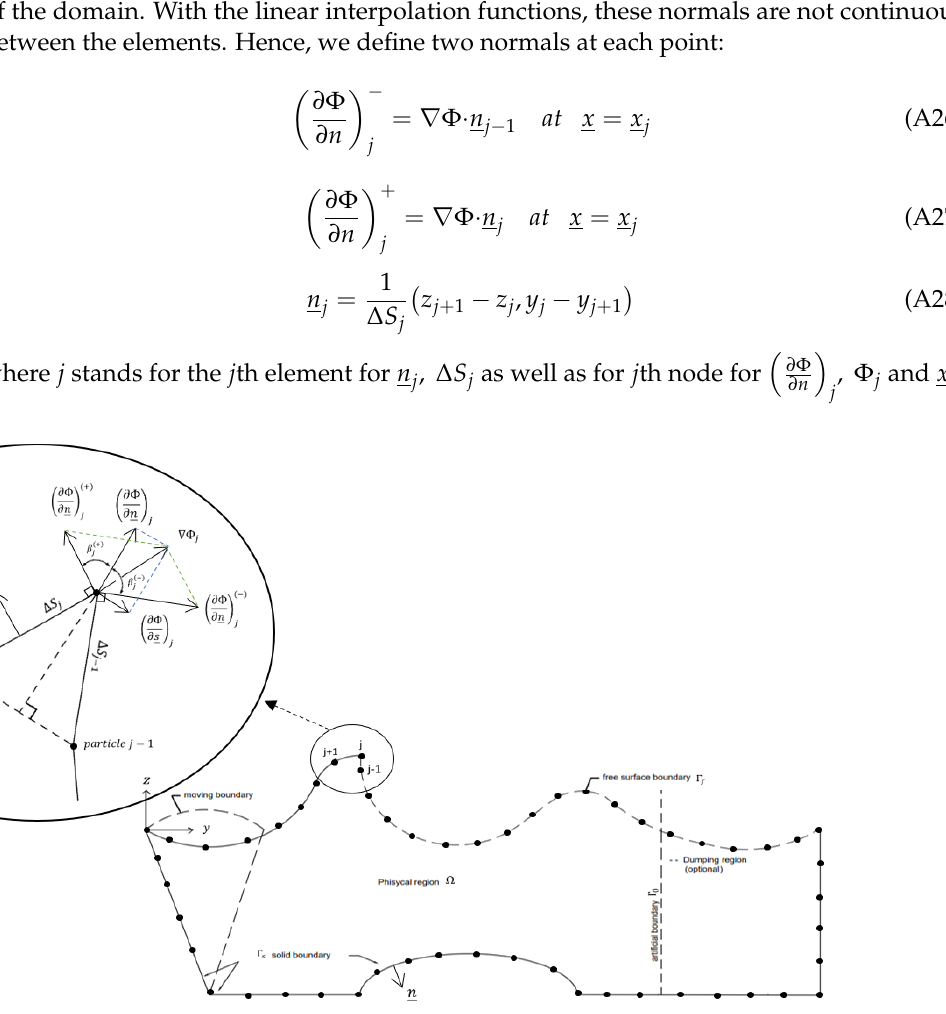
Figure A3. The boundary elements model scheme.